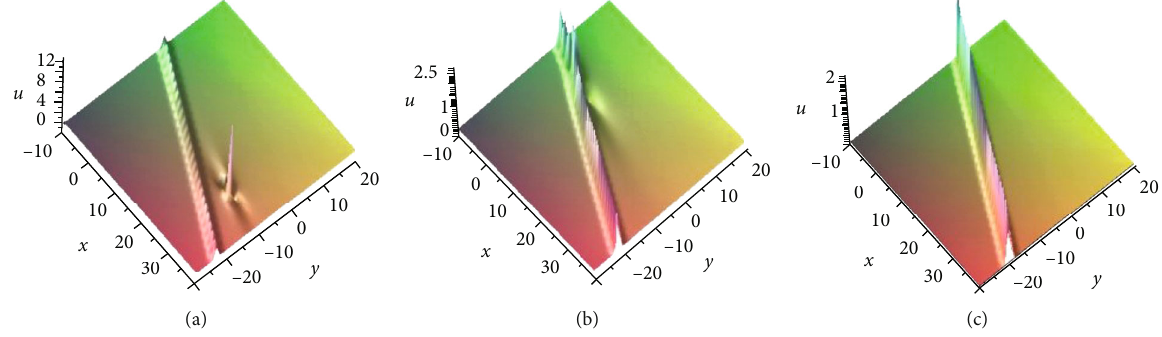
= 1 + i , q = 1 − i , a = 1 , b = 1 , τ = 0 , c 1 1